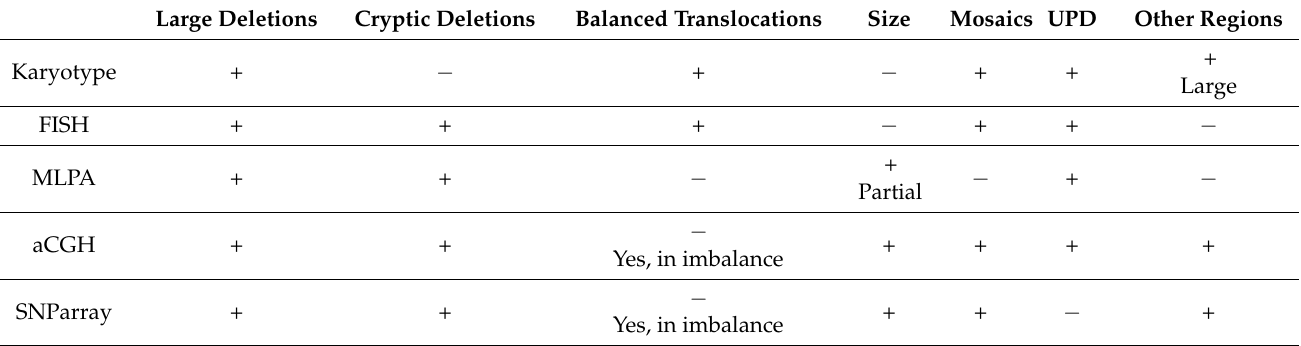
Table 2. List of advantages and disadvantages of laboratory techniques in the diagnosis of PMS.